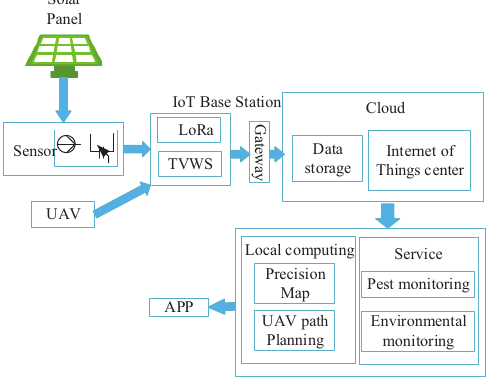
Figure 1. Overview of the agricultural IoT